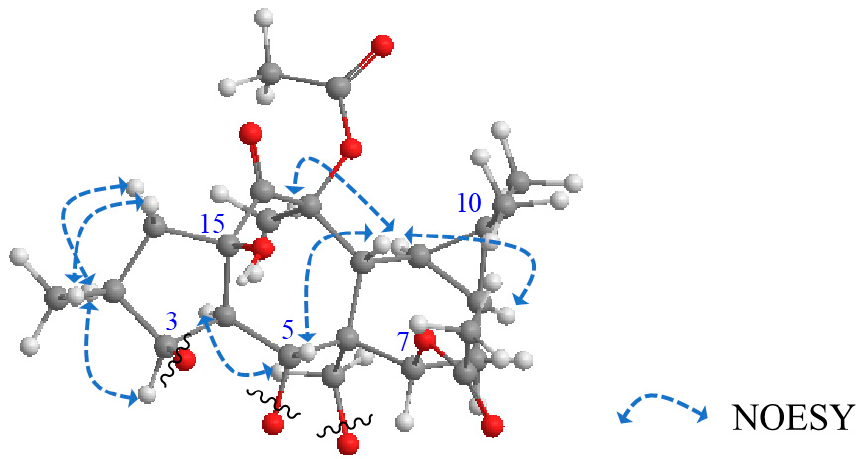
Figure 3. Significant NOESY correlations of 1 – 3 . Table 1. 1 H (600 Hz) and 13 C (150 Hz) NMR (CDCl 3 ) of 1 – 3 a,b